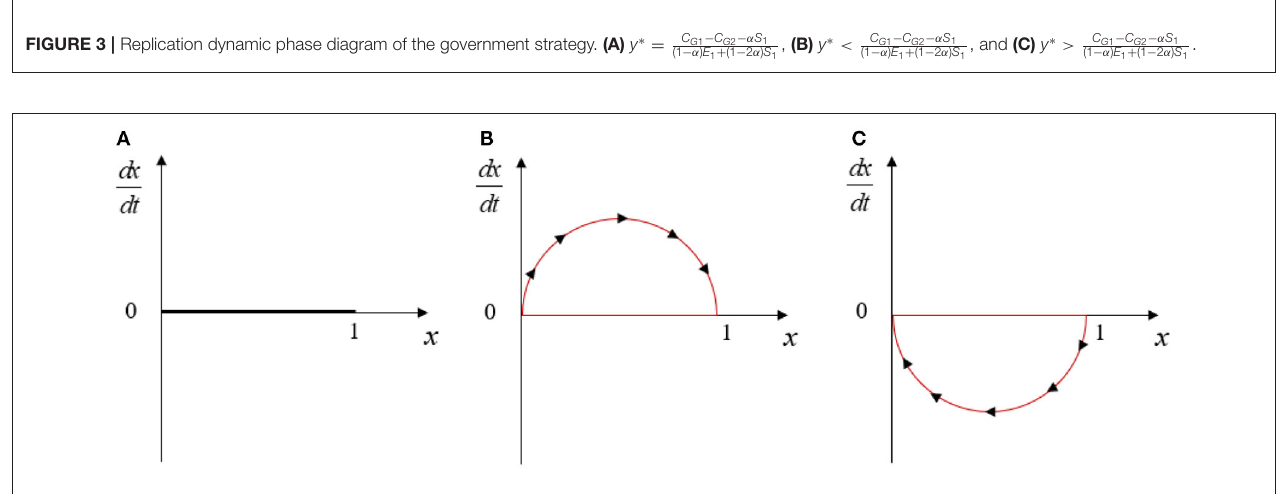
FIGURE 4 | Replication dynamic phase diagram of enterprise strategy. (A) x ∗ = − γ W 2 − ( β − 1) S 2 − C E 2